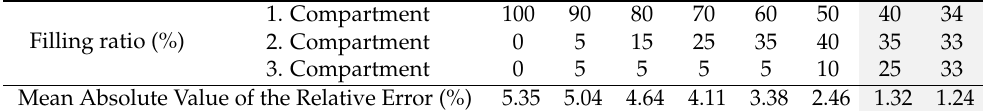
Table 7. Relative error of die filling ratio configuration regarding the tablet weight. Filling ratio